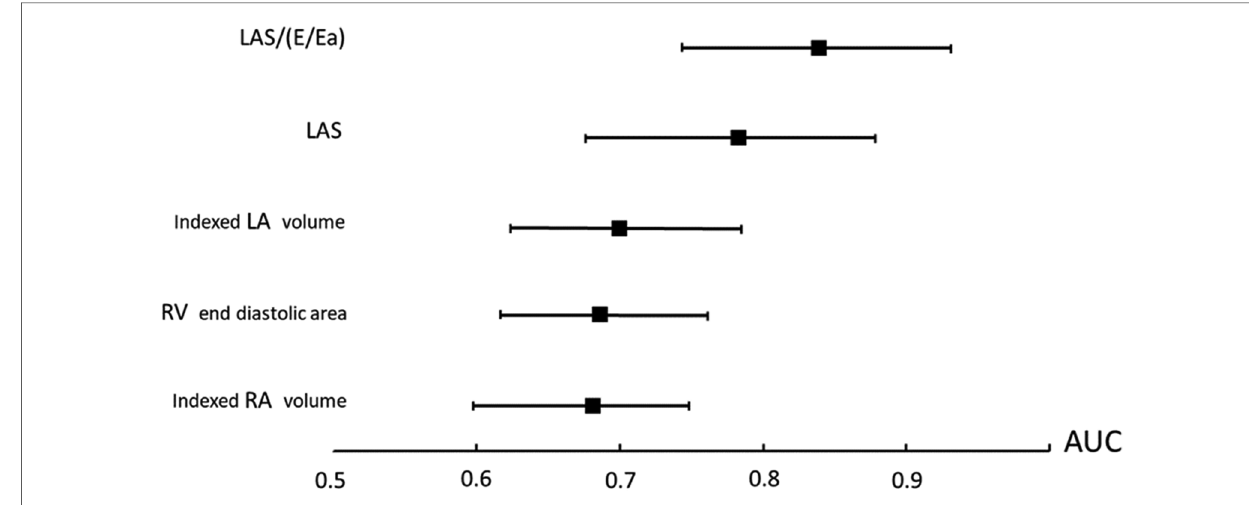
FIGURE 4 Comparisons of area under the curve. LA, left atrium; LAS, left atrial strain (reservoir function); Ra, right atrium; RV, right ventricle.